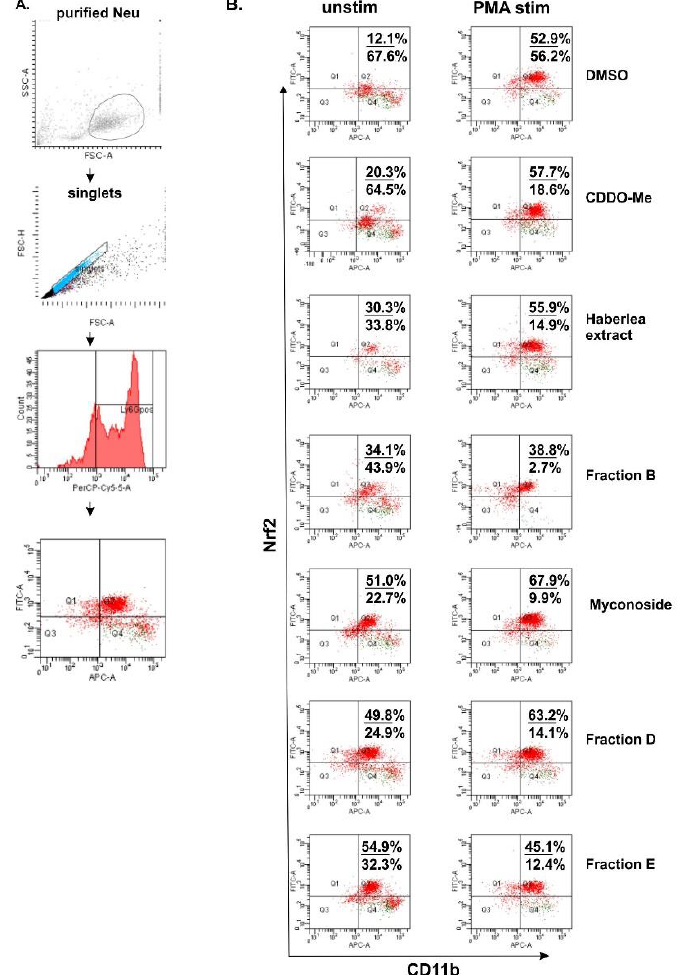
Figure 3. Flow cytometry analysis for the detection of endogenous nuclear factor erythroid 2 p45- related factor 2 (Nrf2) in bone marrow neutrophils. ( A ) Gating strategy involving the elimination of duplets. ( B ) Representative dot-plots showing the percentages of CD11b + Nrf2 + neutrophils unstimulated or stimulated with phorbol 12-myristate 13-acetate (PMA) for 16 h and the analysis of collected 20,000 cells per sample. Dot-plot represents four quadrant images, Q1: CD11b − and Nrf2 + , Q2: CD11b + and Nrf2 + , Q3: CD11b − and Nrf2 − , and Q4: CD11b + and Nrf2 − . The numbers on the dot-plots indicate the frequencies of CD11b + Nrf2 + cells/CD11b + Nrf2 − cells. Neutrophil stimulation with PMA increased the percentage of CD11b + Nrf2 + neu- trophils in all the groups in comparison to the respective unstimulated groups. However, Nrf2 to a greater extent than CDDO-Me (Figure 3B). Overall, the PMA stimulation of